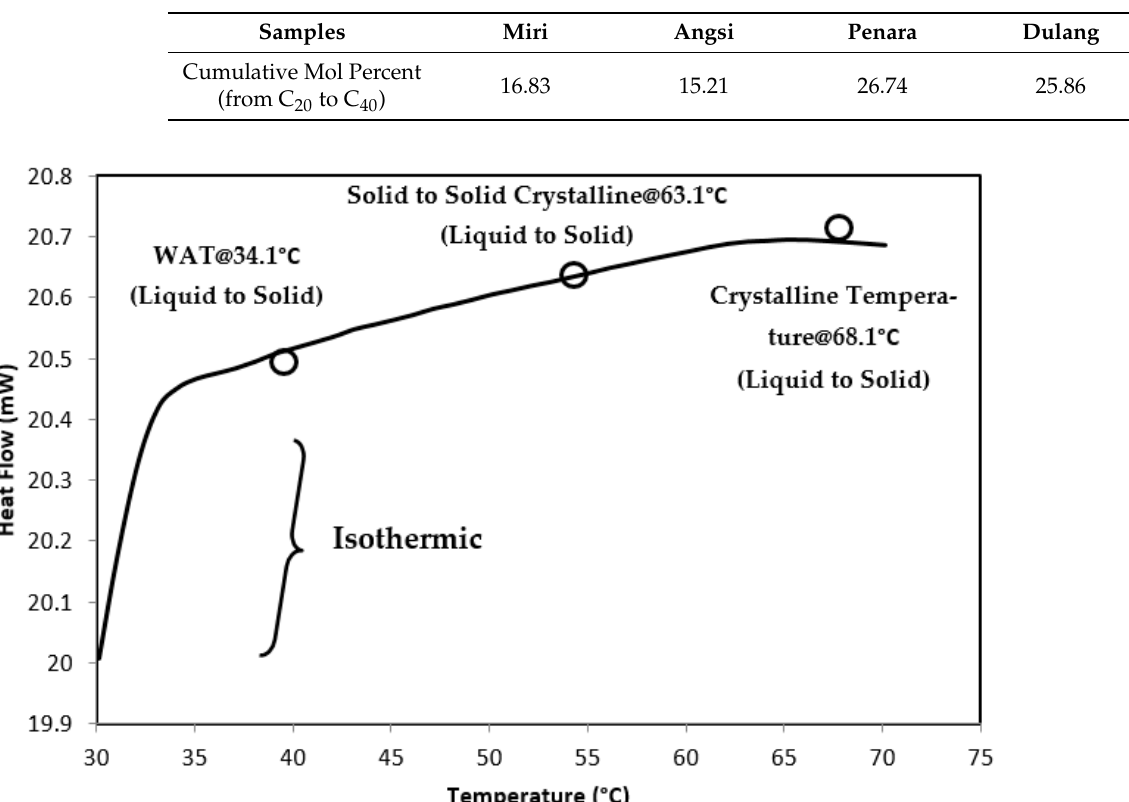
Table 3. Cumulative mol percent from (C ₂₀ to C ₄₀ ) for each sample.